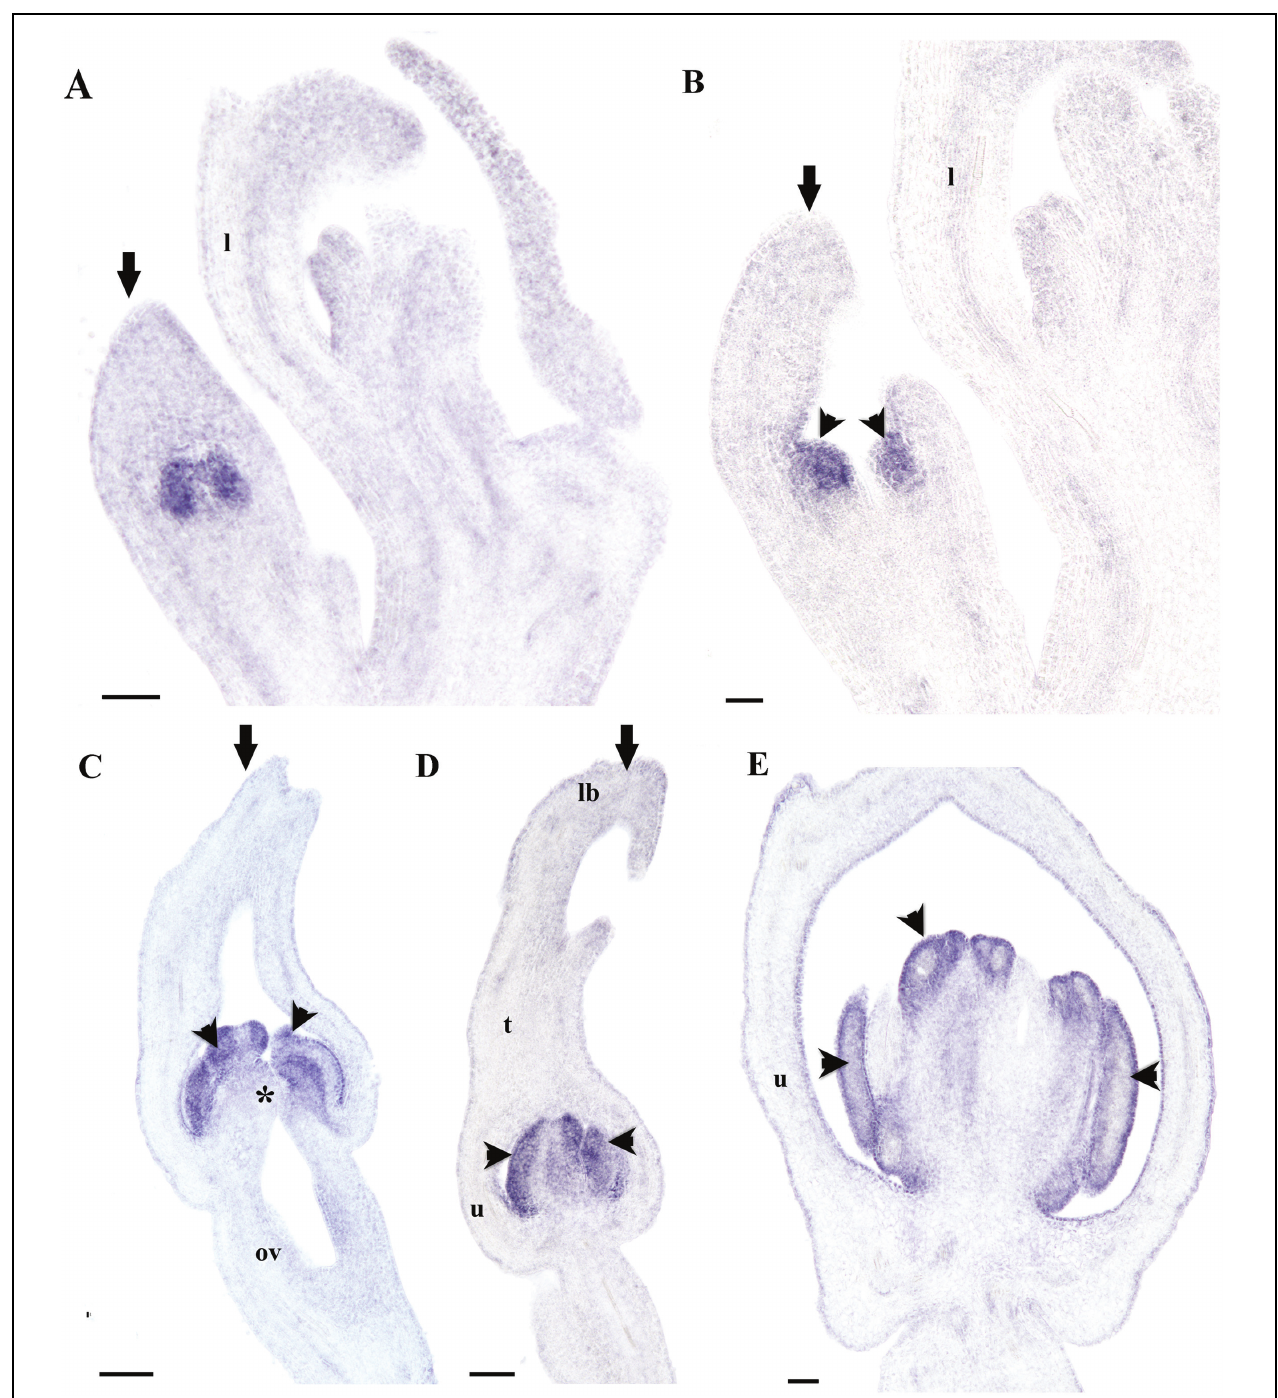
FIGURE 9 | In situ hybridization of AfimAP3 . (A,B) Flowering shoot apex in longitudinal sections; note expression restricted to stamens. (C–E) Successive stages S5-S7 showing initiation of the stigmatic lobes at S5 (C) , and elongation at S6–S7 (D,E) ; note expression restricted to stamens. Black arrows indicate medial sepal; black arrowheads indicate anthers; asterisk ( ∗ ) indicates a stigma; l, leaf; lb, limb; ov, ovary; t, tube; u, utricle. Scale bars: (A–D) : 100 μ m; (E) : 150 μ m.